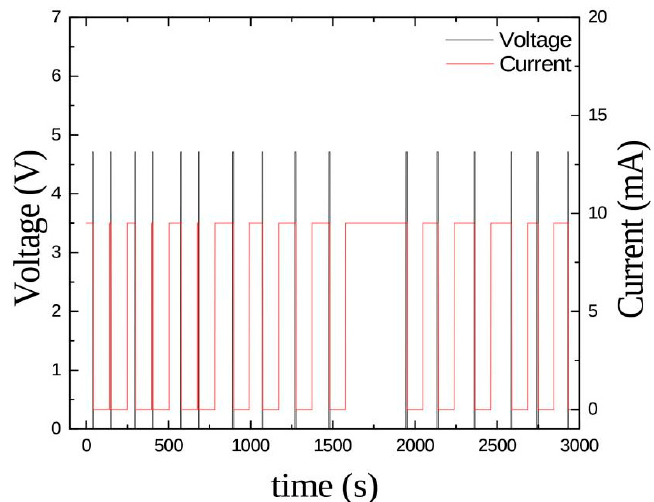
Figure 6. V-t data for an NbN strip detector. The voltage plateau corresponds to waiting times in the ready state, until an event occurs and a voltage spike is measured. Voltage is measured directly at the strip, with no amplification. (Adapted from [12], with the permission of IOP Publishing).